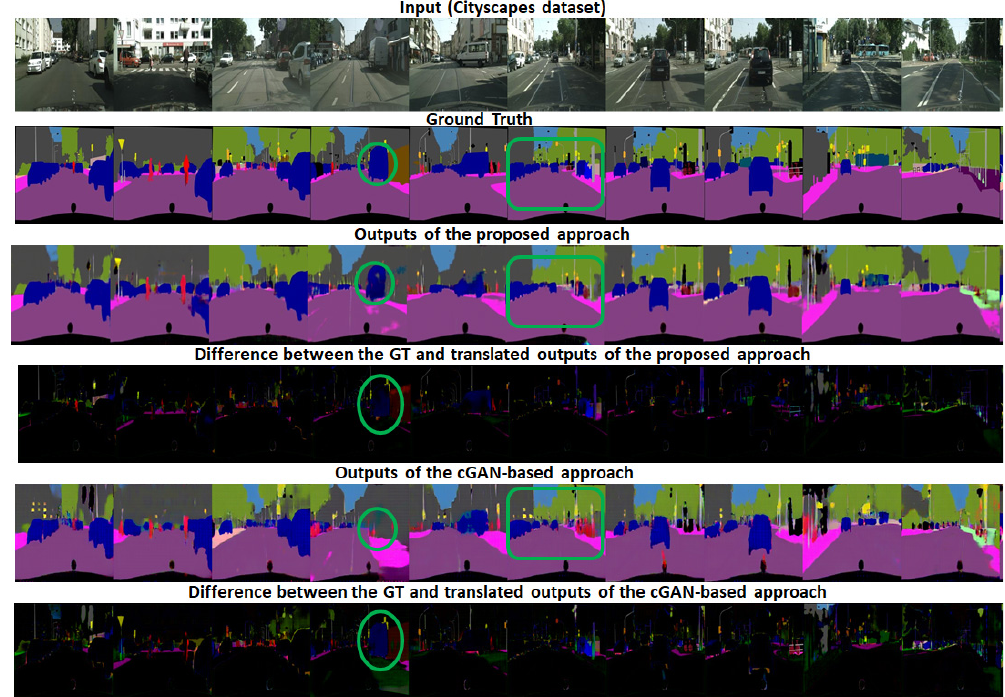
Figure 3. Input test samples in domain x are translated to domain y samples by the proposed approach and cGAN-based approach [10]. Comparative analysis was performed for the difference between the ground truth and images generated by the proposed approach and the cGAN-based